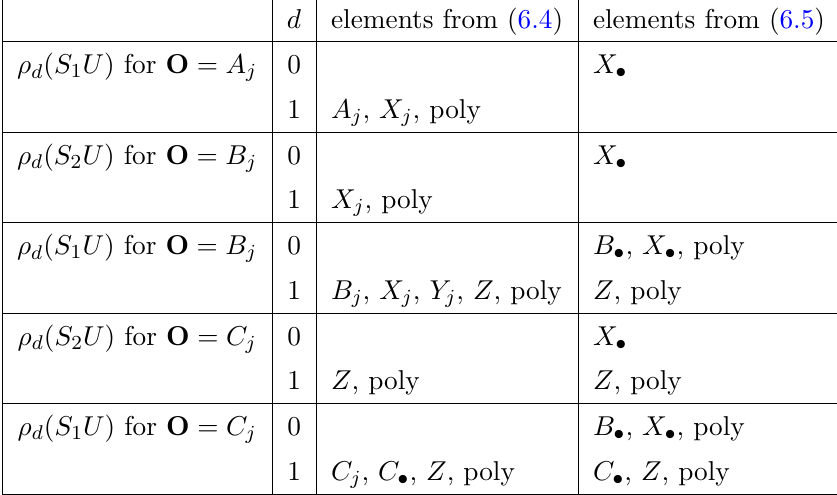
Table 2 . For YM, this table lists elements in (6.4) and (6.5) that suffice to prove membership in I YM as in (6.6a), (6.6b). The list is not necessarily